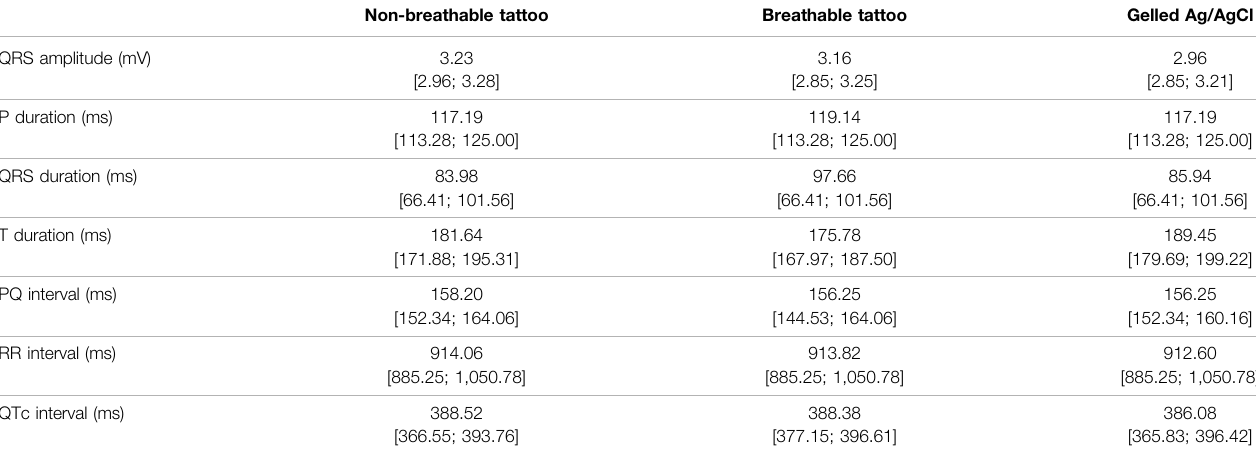
TABLE 1 | ECG measurements for each electrode type in terms of median values and 25th and 75th percentiles (in brackets).